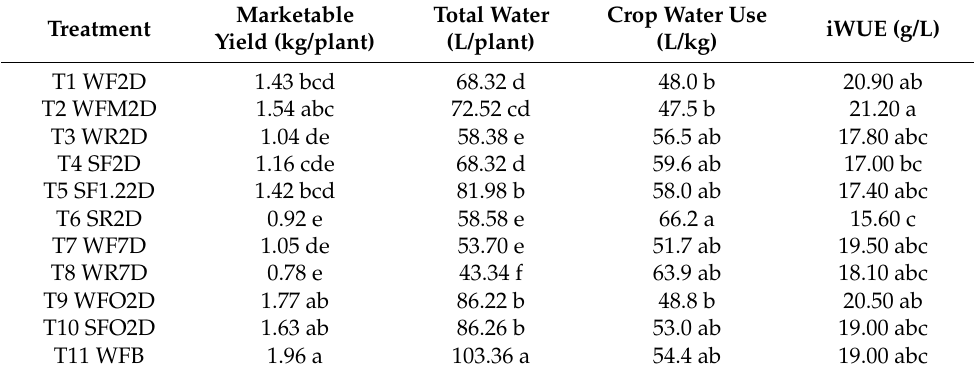
Table 3. Comparison of yield, total water, and iWUE between irrigation treatments. Treatment